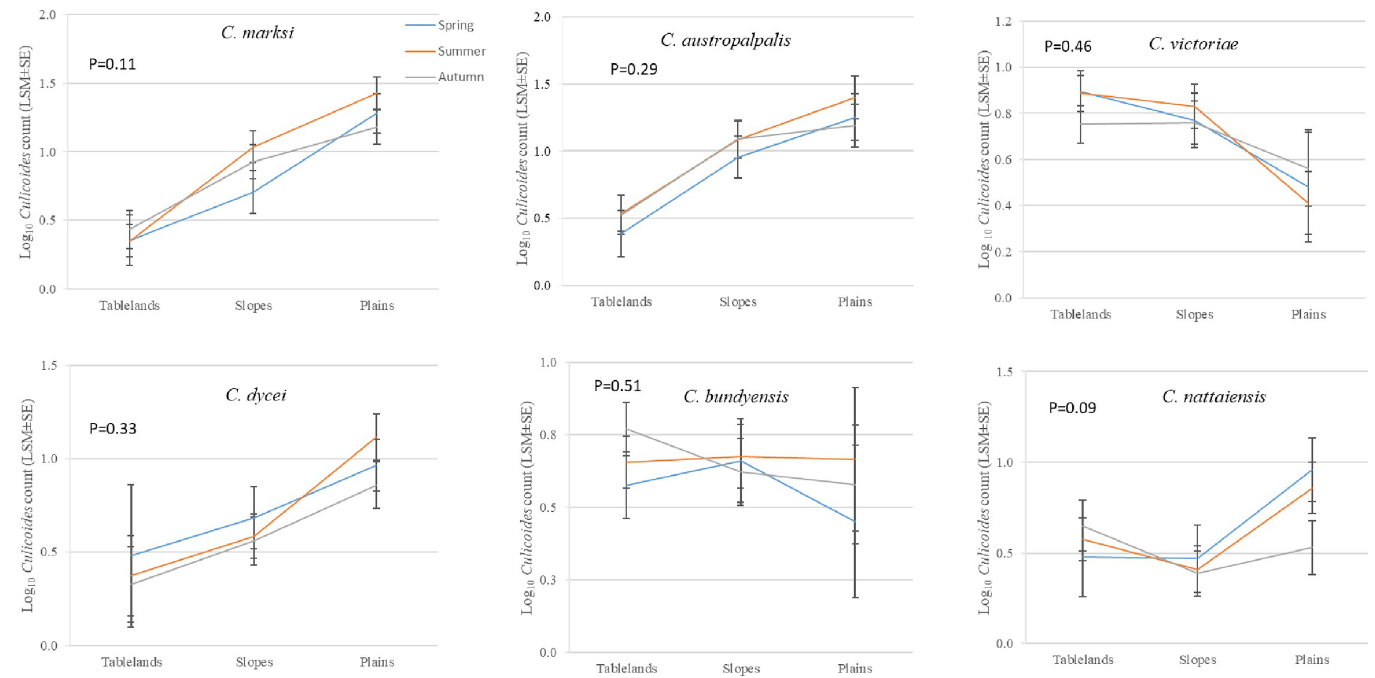
Fig 2. Effect of season and subregion on counts per trapping event (Log 10 , LSM ± SE) of the most abundant Culicoides species trapped in the New England region of NSW, Australia between 1990 and